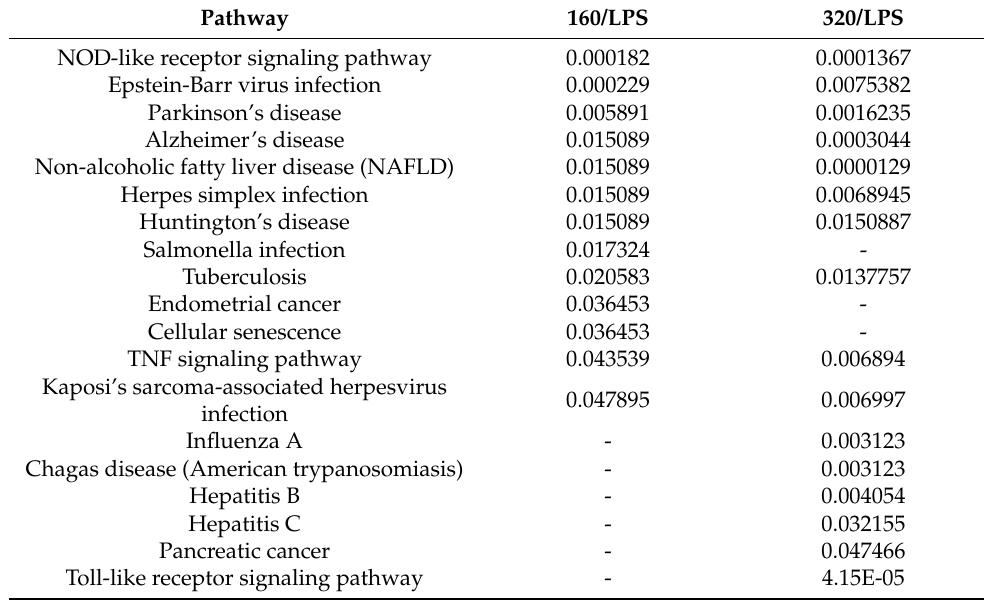
Table 3. The significantly enriched KEGG pathways in the treatment of 160/LPS and 320/LPS.